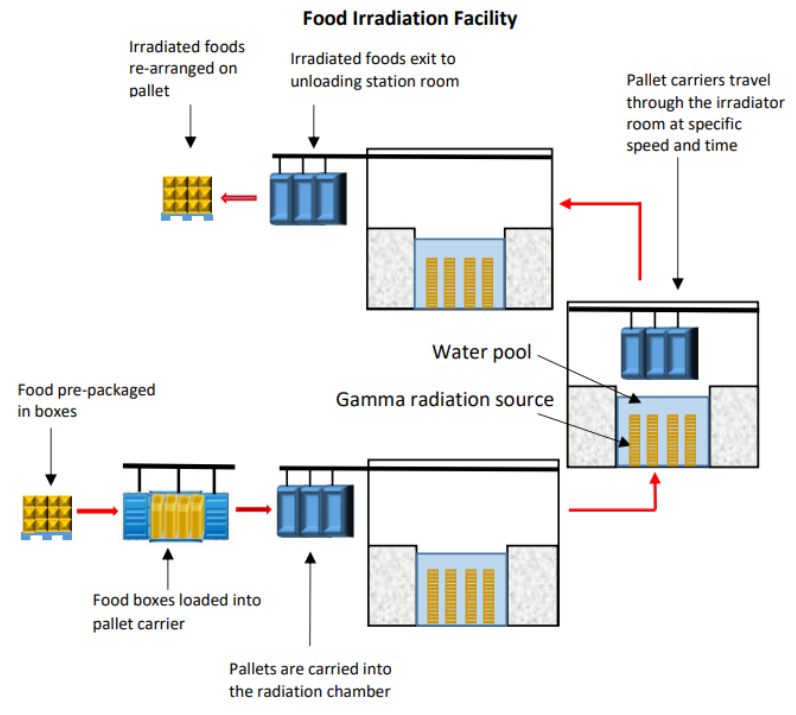
Figure 1. A schematic diagram of a common food irradiation facility.